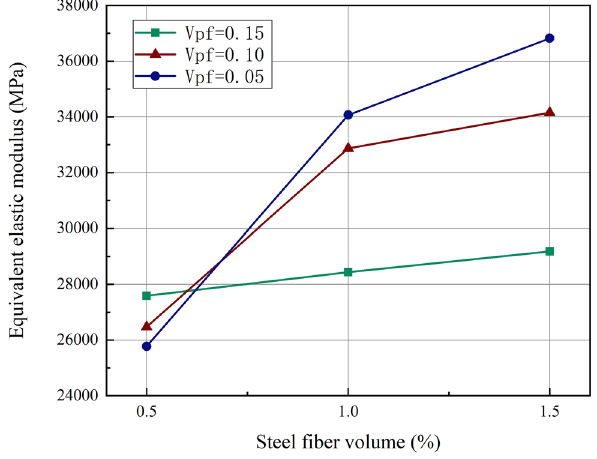
Figure 12: Equivalent elastic modulus of the model for di ff erent fi ber volumes.